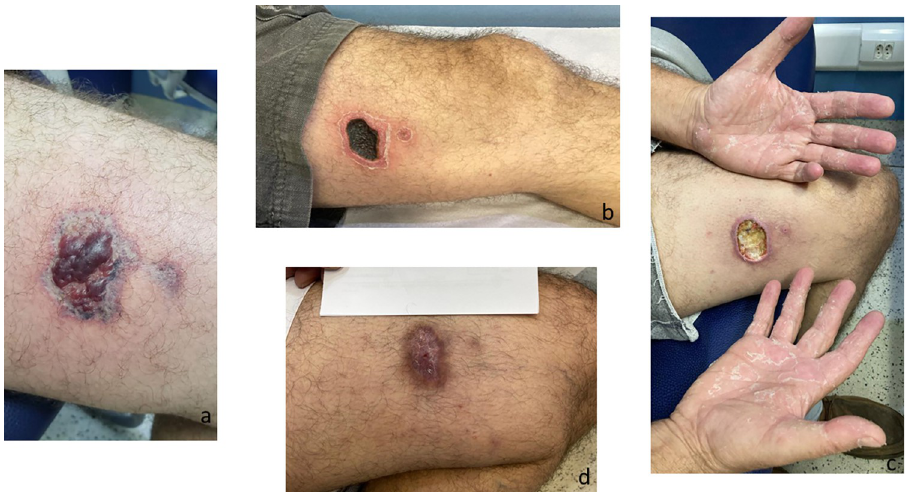
Fig 7. Evolution of a cutaneous lesion after a Loxosceles sp. bite, from marbled macula to necrosis and ulcer. (a) 5 days after the bite; (b) 20 days after the bite; (c) 27 days after the bite, the patient presented an ulcer at the bite site and scaling on the hands; (d) 83 days after the bite, the patient had a scar at the site of the bite but opted not to undergo plastic surgery.